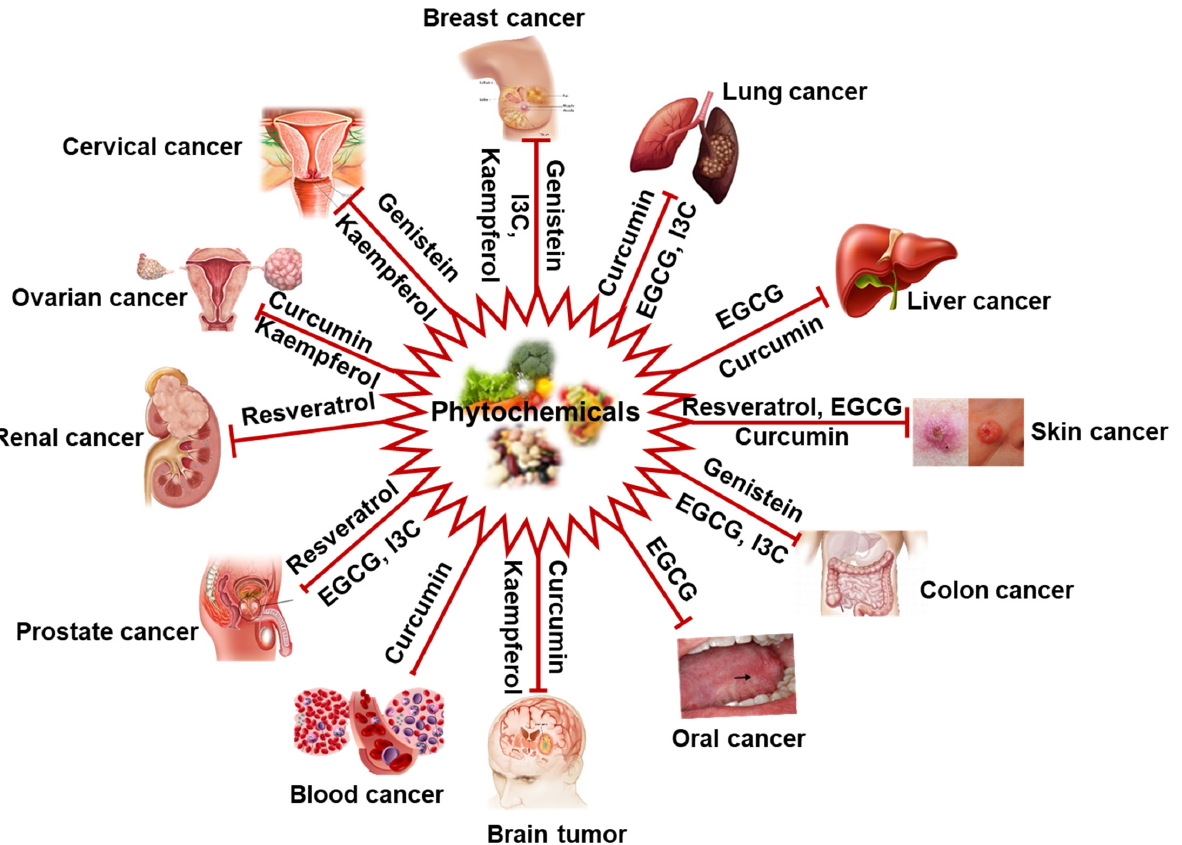
Figure 1. Schematic representation of cancer types that could be prevented/managed by natural products (phytochemicals). IC3, Indol-3-carbinol.